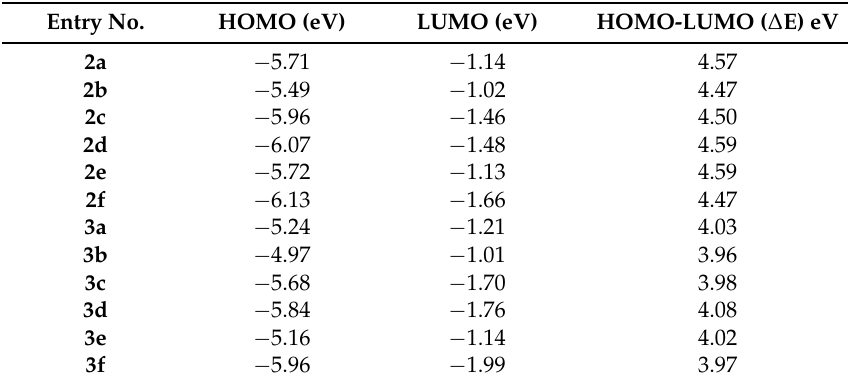
Table 4. HOMO and LUMO energies along with energy gaps.